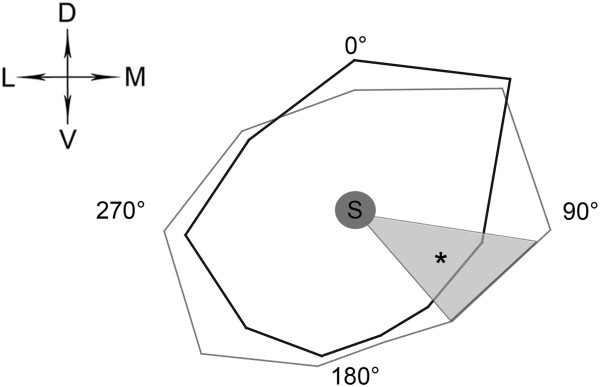
Polar histograms showing angular distributions of dendritic lengths projected to the transverse plane. Full circle around somata (S) was divided into 40 degree angle intervals starting with the dorsal direction (0°), the total lengths of dendritic branches were measured within these intervals and averaged over MNs within the same part of the cord. Mean dendritic lengths were represented on a relative scale by the length of a line drawn from the soma in the given direction and finally end points of these lines were interconnected (gray line for the cervical MNs and black line for lumbar MNs). The direction with the longest dendritic length was taken as 100% for the lumbar and cervical MNs separately. Ventromedial (VM) direction (120–160°), where significant segmental difference in angular distributions of dendrites was detected (Mann–Whitney-test, p < 0.05) is shaded in gray.